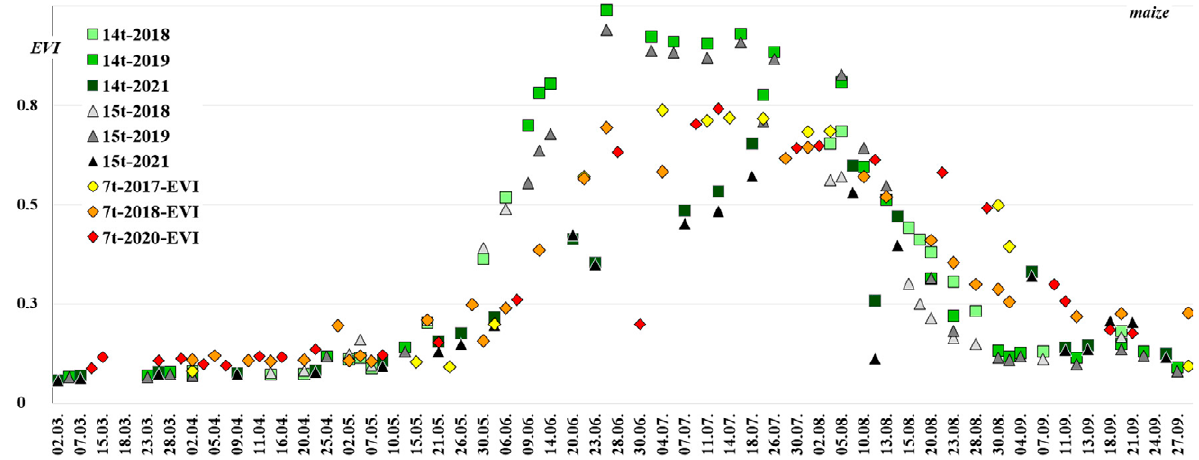
Figure 7. Effect of sewage sludge deposition based on maize Sentinel-2 EVI values on the example of 14t quadrat by comparing 15t, 7t control